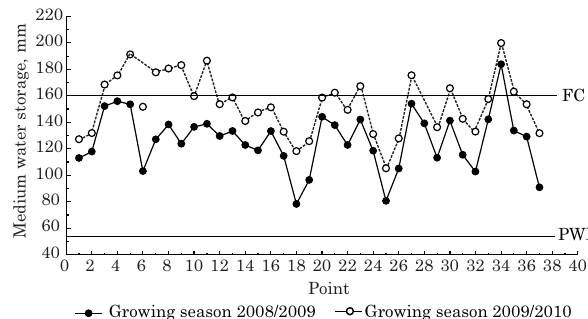
Figure 5. Medium water storage evaluated at each point in the 0.00-0.30 m layer of a Cambisol, in the growing seasons 2008/2009 and 2009/2010. FC: Field capacity; PWP: Permanent wilting point determined by psychrometer (WP4).